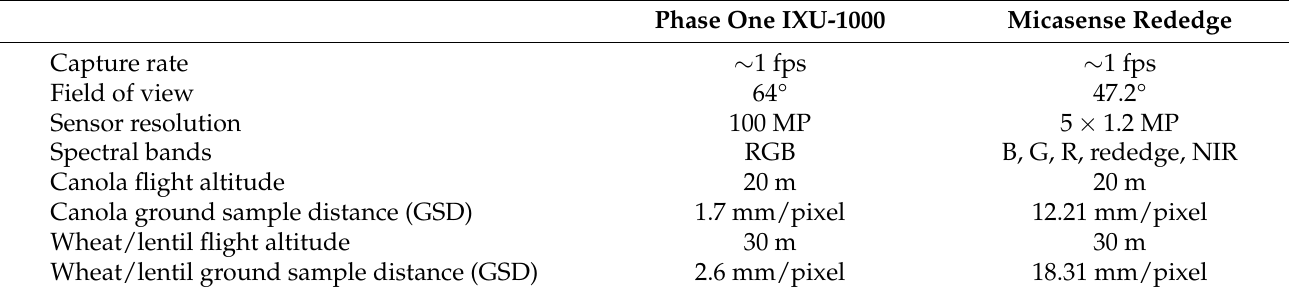
Table 2. Configuration comparison between Phase One IXU-1000 and Micasense Rededge